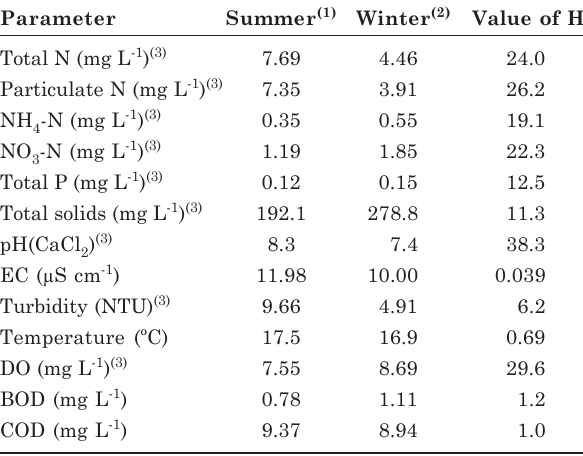
Table 9. Summer and winter average